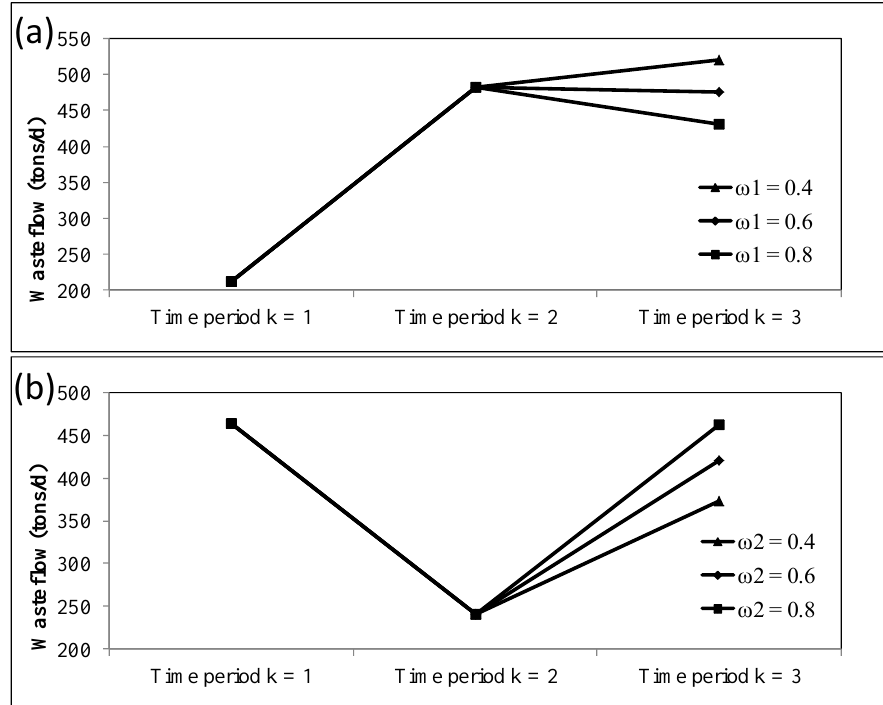
Figure 1. Total waste flow to facilities under different  levels when Climate 2019 , 7 , x FOR PEER REVIEW ( b ) to incinerator.